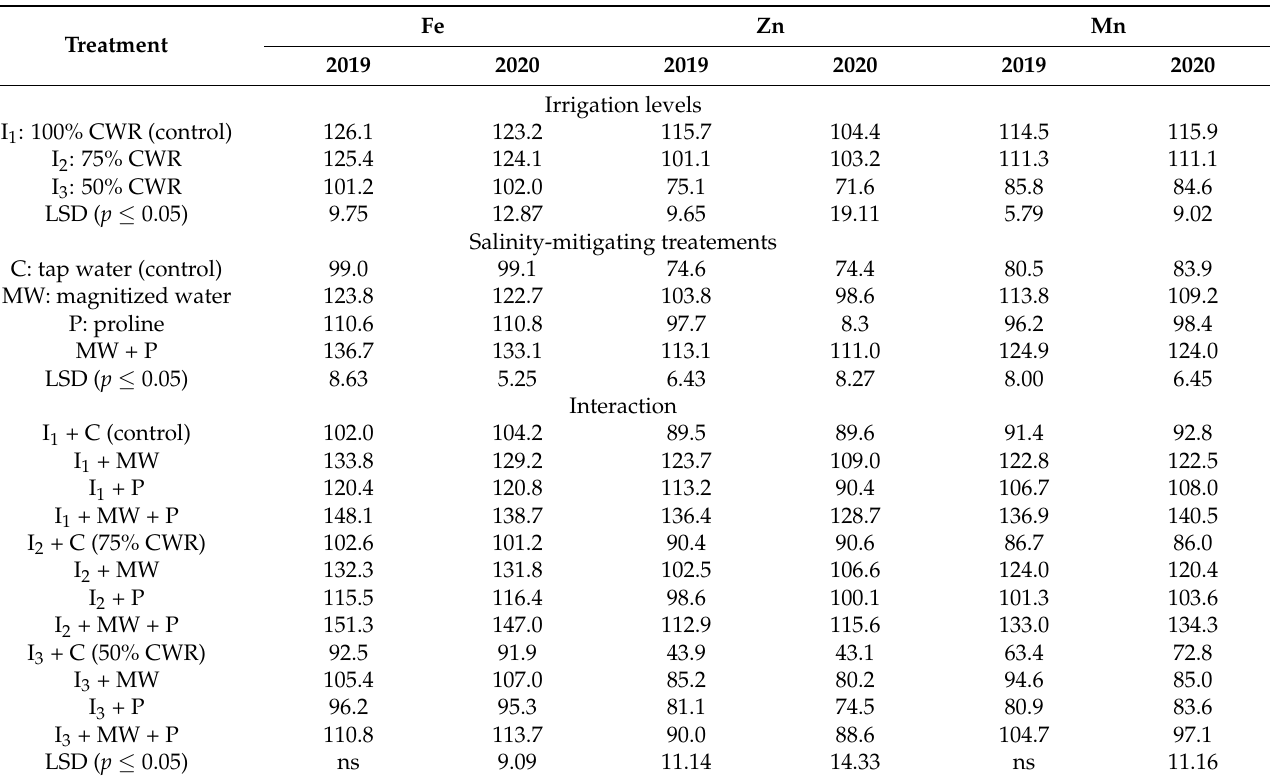
Table 5. Effect of MW, P, and MW + P on leaf micronutrient contents (mg · L − 1 dw) of “Taifi” pomegranate shrubs grown under different irrigation regimes (I 1 , I 2 , and I 3 ), based on CWR, during the 2019 and 2020